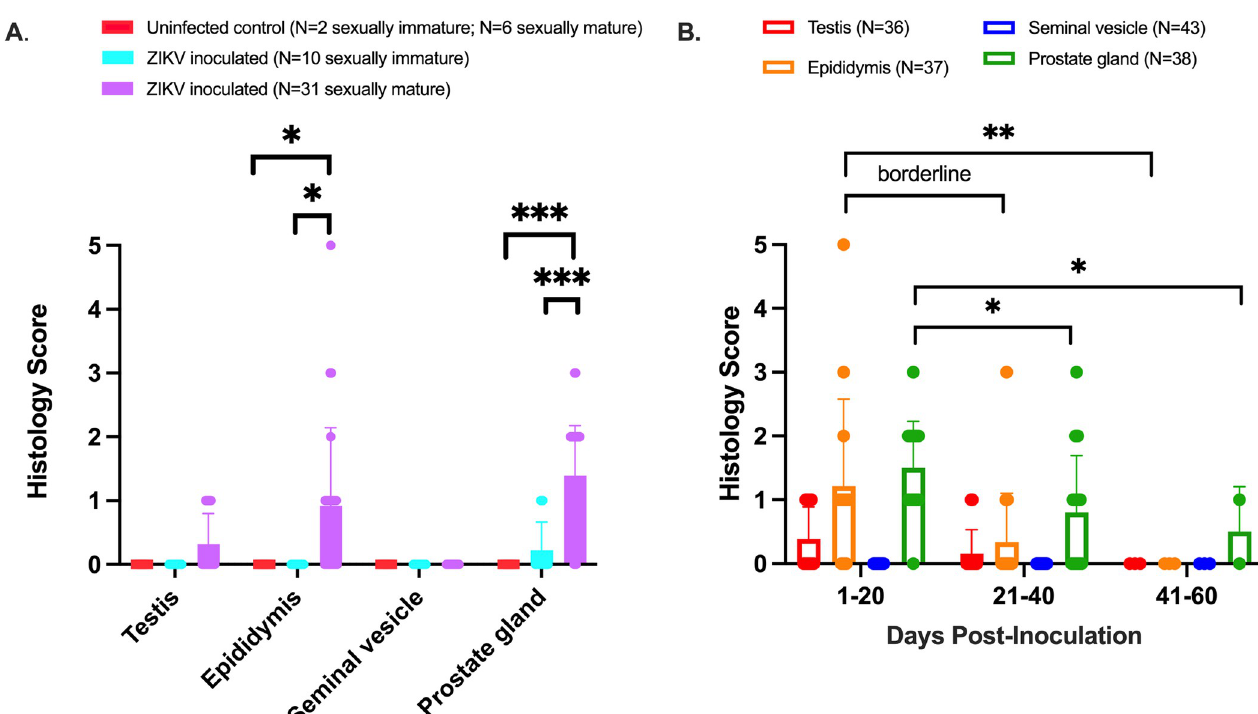
Fig 5. Sexual maturity and duration of ZIKV infection impact histopathologic lesion severity in male macaque reproductive tissues. Macaque genital tissues were scored histologically from 0 (normal) to 5 (markedly abnormal). A.) Pathology severity scores for sexually mature and immature ZIKV-inoculated male macaques and uninfected, age-matched controls B.) Pathologic lesions were more likely to occur between 1 and 20 DPI in the epididymis and prostate gland (vs. 21–40 and 41–60 DPI). Each dot represents an individual macaque. Bars show the mean histology score, and error bars show standard deviation. Sexually immature = 0–4 years old; sexually mature = > 4 years old. Mann-Whitney: ns, p value > 0.08; borderline, p value between 0.05 and 0.08; � , p value � 0.05; �� p value � 0.01; ��� , p value � 0.001.